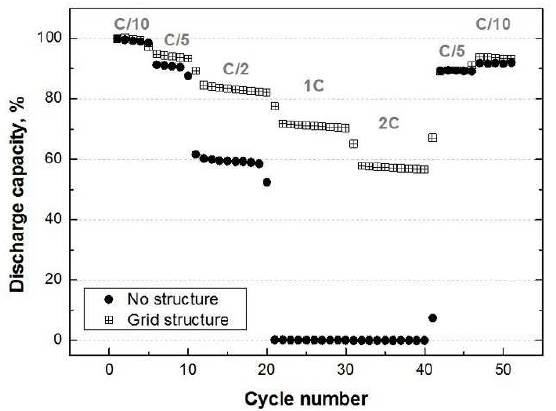
Figure 3. Discharged capacity determined by galvanostatic cycling with potential limitation using different C-rates, performed on reference- and laser-cells.